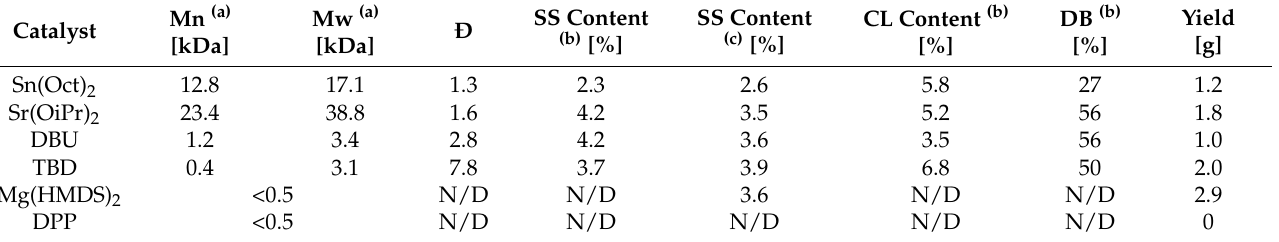
Table 1. Polymer synthesis and catalyst screening for polymerizations.